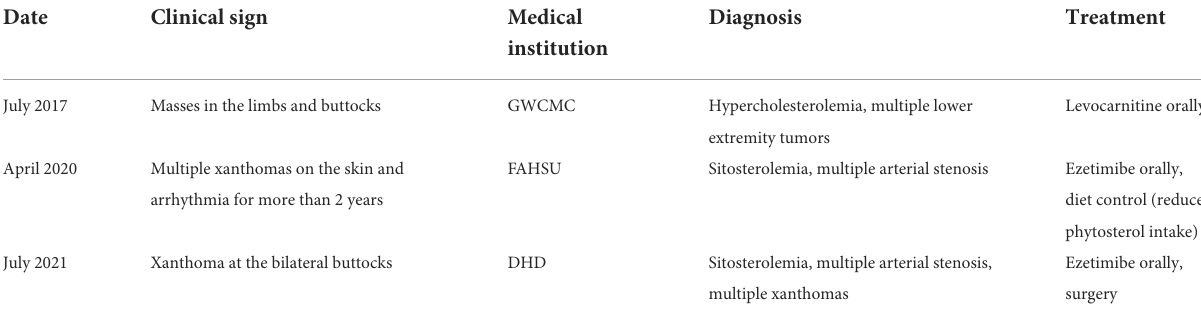
TABLE 1 Basic information of Case 1 from onset to